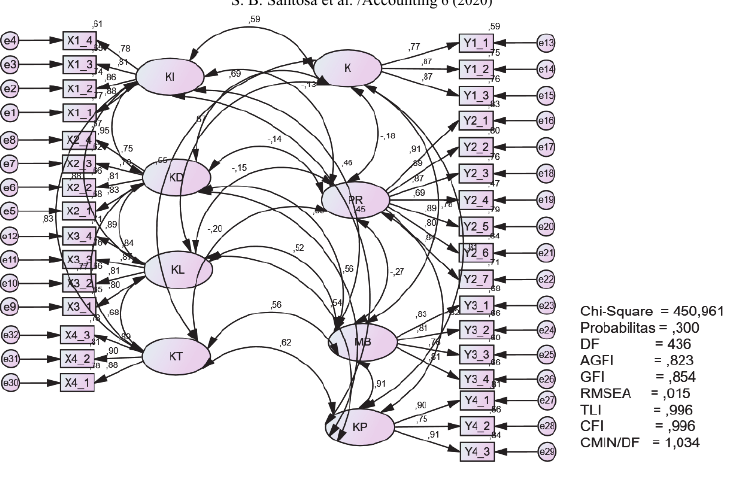
Fig. 2. The results of testing the hypotheses of the survey Source: primary data,